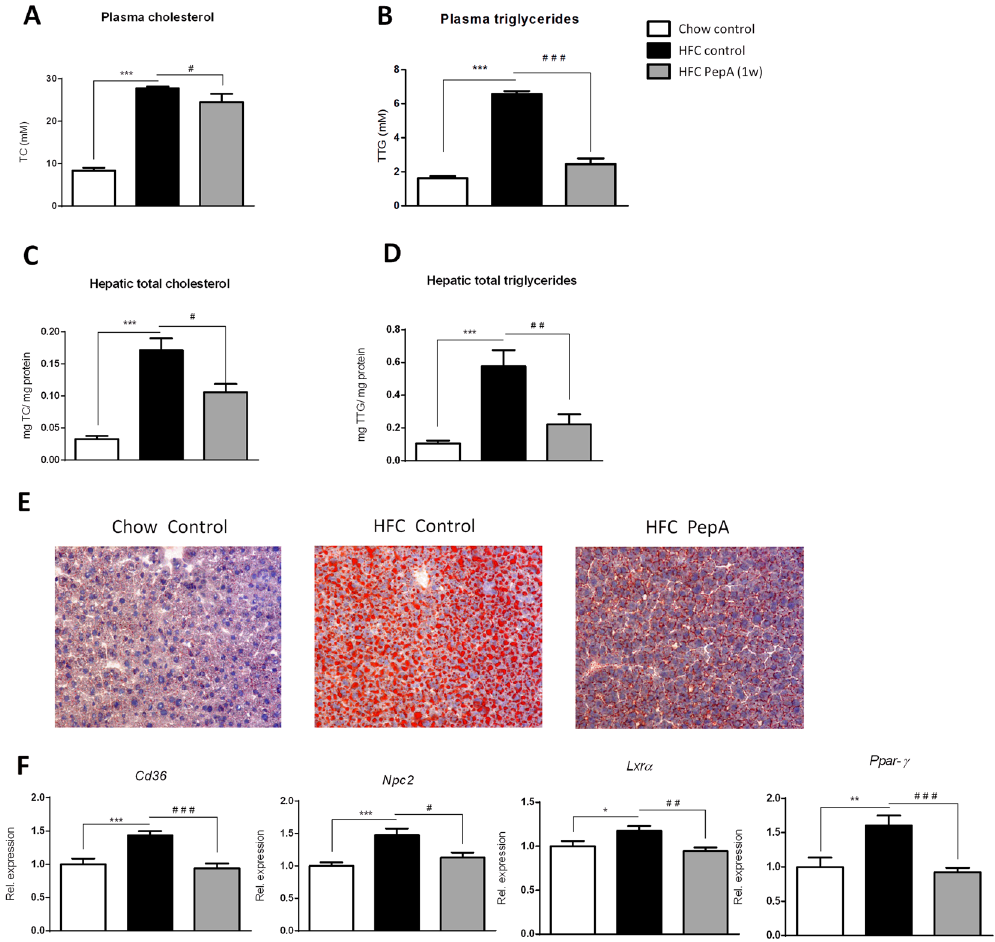
Figure 3. Plasma and hepatic lipids in hyperlipidemic mice with or without PepA-treatment. ( A,B ) Plasma total cholesterol and triglyceride measurements. ( C,D ) Total hepatic cholesterol and hepatic triglyceride measurements. ( E ) Representative pictures (original magnification, 200x) of the Oil red O staining. ( F ) Gene expression analysis of Cd36 , Npc2 , Lxr α and Ppar- γ . Gene expression data are shown relative to control mice on chow diet. Error bars represent ± SEM; * indicates p ≤ 0.05, ** p < 0.01 and *** p < 0.001 compared to mice on chow diet; # indicates p ≤ 0.05, ## p < 0.01 and ### p < 0.001 compared to control-injected mice on HFC diet by use of two-tailed unpaired t test. n = 9–11 animals for each group